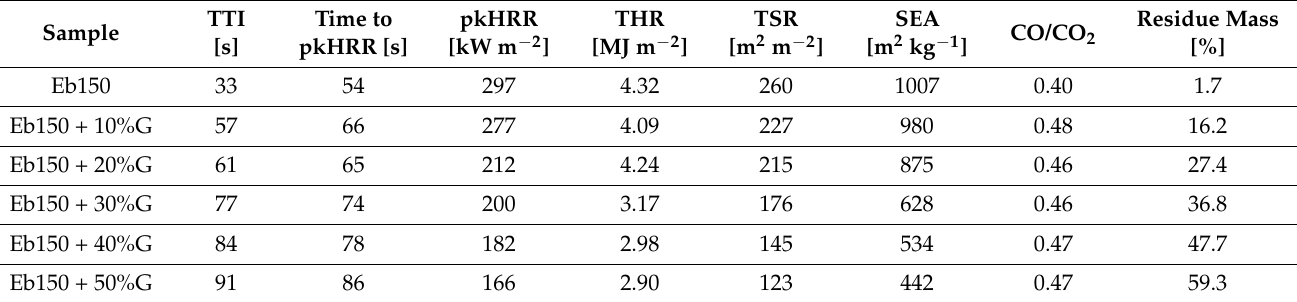
Table 3. Results from cone calorimetry tests performed on UV-LED cured